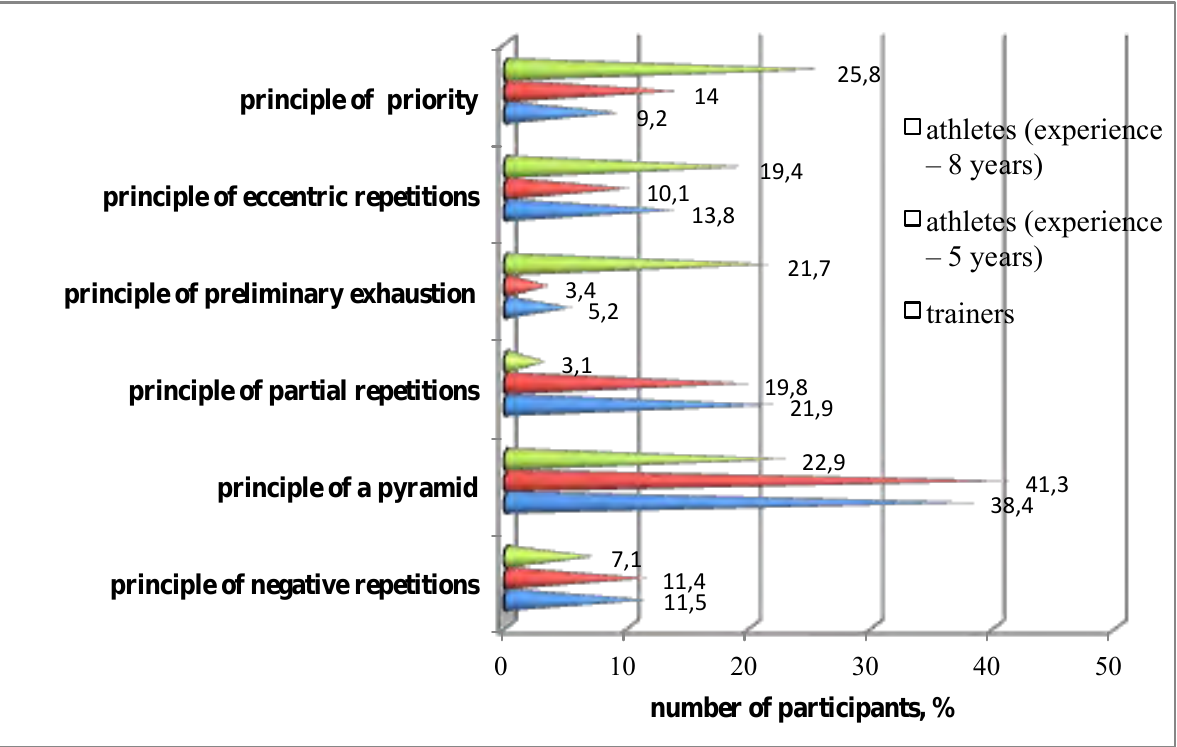
Fig. 1. The training principles which are used to lower traumatism level at the stage of a specialized basic training,